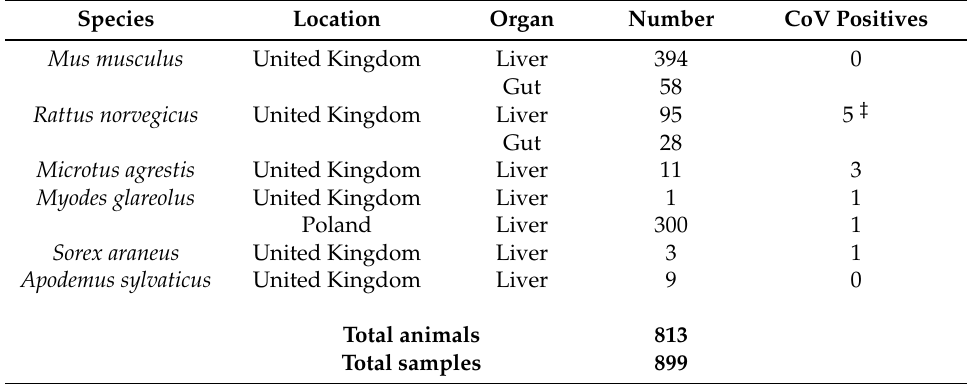
Table 1. List of animal species, location, organ, specimen tally and number of CoV positive